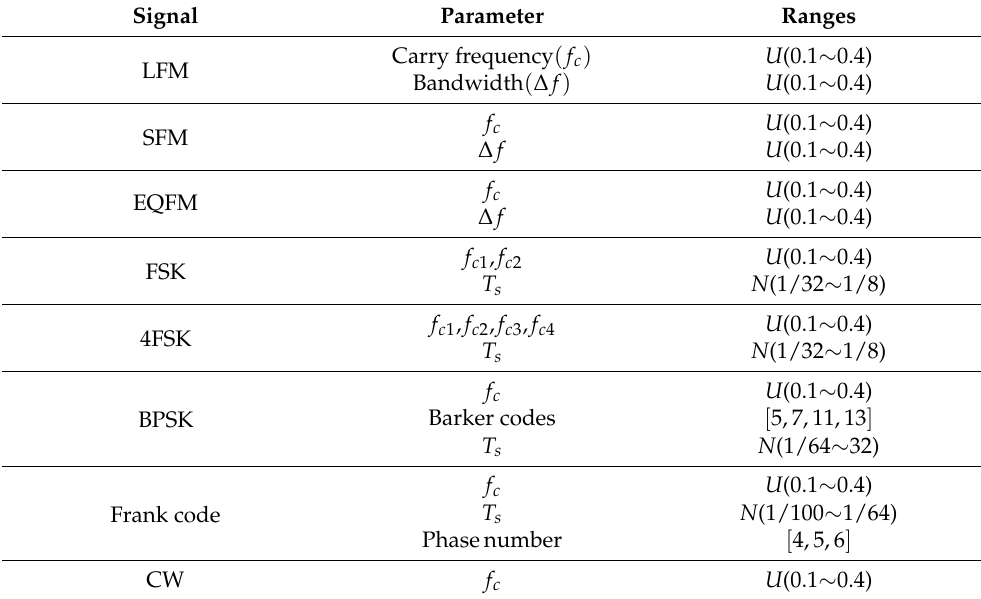
Table 2. Parameters of simulation radar